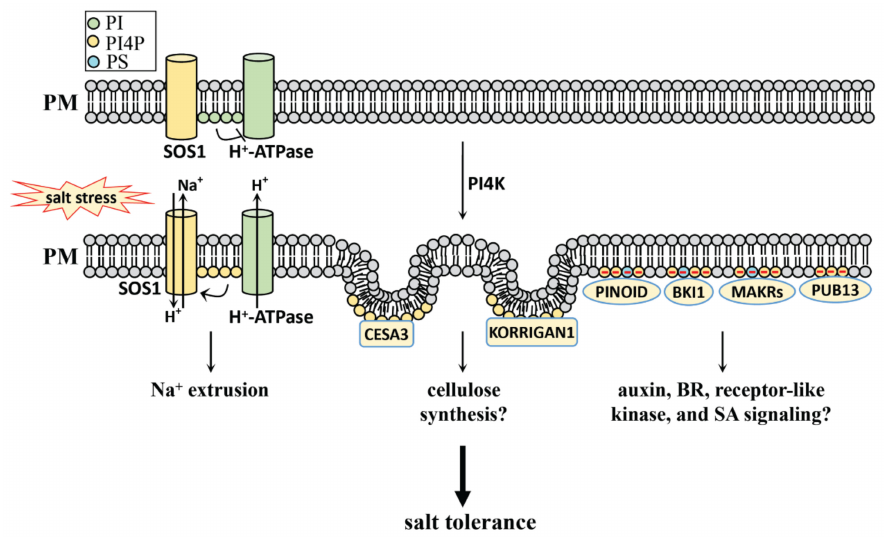
Figure 2. The regulatory role of PI4P in the salt stress response of plants. PI4P level is induced by salt stress. PI binds PM H + -ATPase and inhibits its activity under normal conditions without salt stress; however, under salt stress condition, PI4P derived from PI stimulates SOS1 activity and excludes excess Na + from plant cells; PI4P also mediates the internalization of CESA3 and KORRIGAN1 from the plasma membrane, which may participate in salt stress response through the regulation of cellulose synthesis; PI4P at the plasma membrane generates an electrostatic field, which may interact with PINOID, BKI1, MAKRs, and PUB13, and participate in salt stress response. PI, phosphatidylinositol; PI4P, PI 4-phosphate; PS, phosphatidylserine; PM: plasma membrane; SOS1, salt overly sensitive 1; BKI1, BRI1 kinase inhibitor 1; MAKRs, membrane associated kinase regulators; PUB13: PLANT U-BOX13; BR, brassinosteroid; SA, salicylic acid. PI4P and PI(4,5)P 2 are mostly localized at the plasma membrane in Arabidopsis ,